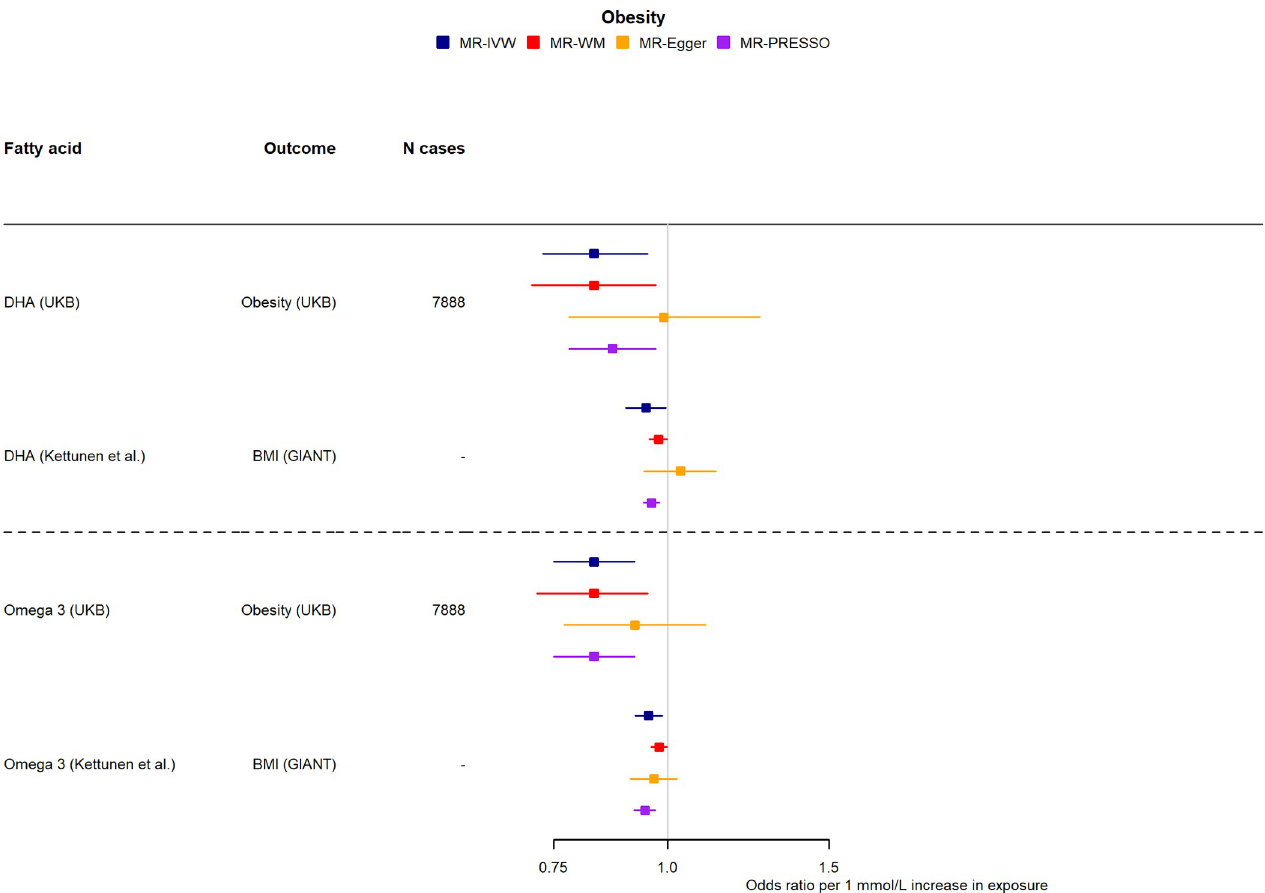
Fig 6. Two-sample MR effect estimates per 1 mmol/L higher fatty acids for obesity in (a) UKB and (b) using Kettunen and colleagues’ [20] betas for fatty acids and betas from GIANT [21] for BMI. Only associations with statistically significant ( P < 0.05) IVW MR estimates in the discovery phase are shown. BMI, body mass index; DHA, docosahexaenoic acid; IVW, inverse-variance weighted; MR, mendelian randomisation; MUFA, monounsaturated fatty acid; total FA, total fatty acid; UKB, UK Biobank; WM, weighted-median.